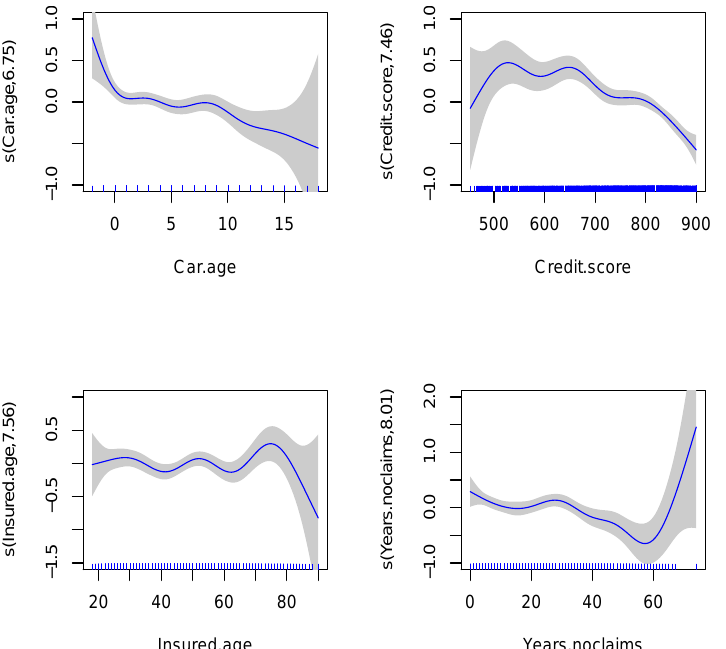
Figure 7. The plots of fitted spline functions, respectively, for Car age, Credit Scores, Annual miles drive, and Years of no